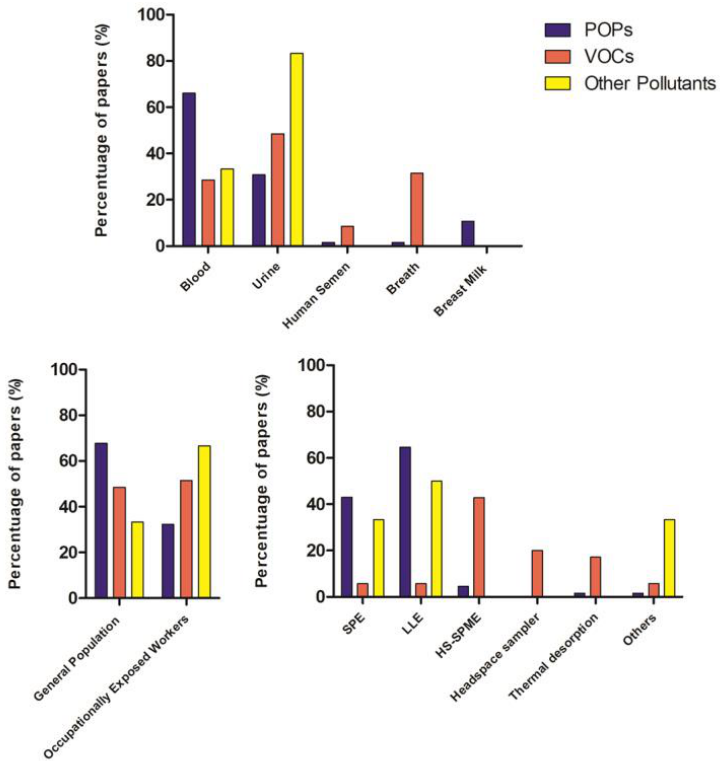
Figure 4. Column charts related to biological fluid, type of population, and extraction method reported in the papers of the systematic review in relation to pollutant classes.